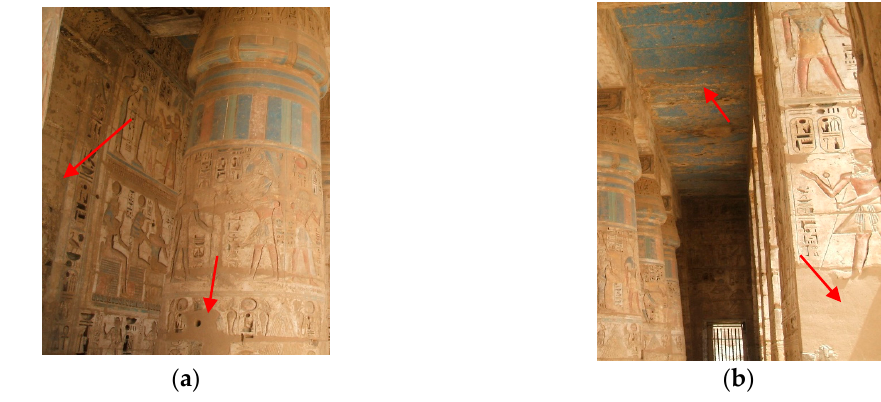
Figure 8. The walls Deterioration in Medinet Habu temple ( a , b ).